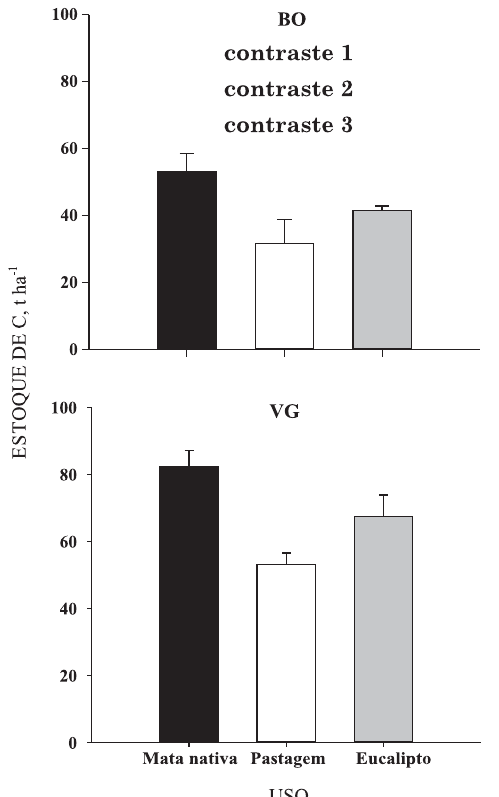
Figura 1. Estoques de carbono orgânico total (COT) na profundidade de 0–20 cm nos solos sob mata nativa, pastagem e eucalipto em Belo Oriente (BO) e Virginópolis (VG). Contraste 1 (mata nativa vs pastagem), contraste 2 (mata nativa vs eucalipto, contraste 3 (eucalipto vs pastagem). *: significativo a 5 %. As barras de desvios verticais representam o desvio-padrão da média (n =